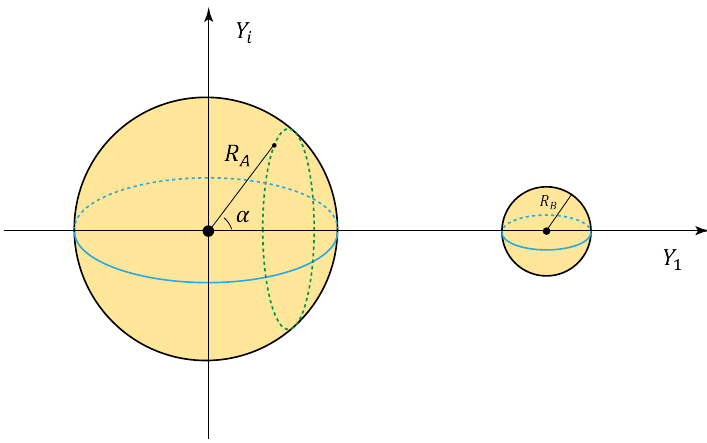
Figure 5 . The setup of spherical frame coordinates Y . The center of the sphere A has been set to the origin. While that of sphere B is located at Y defined as the angle relative to the Y